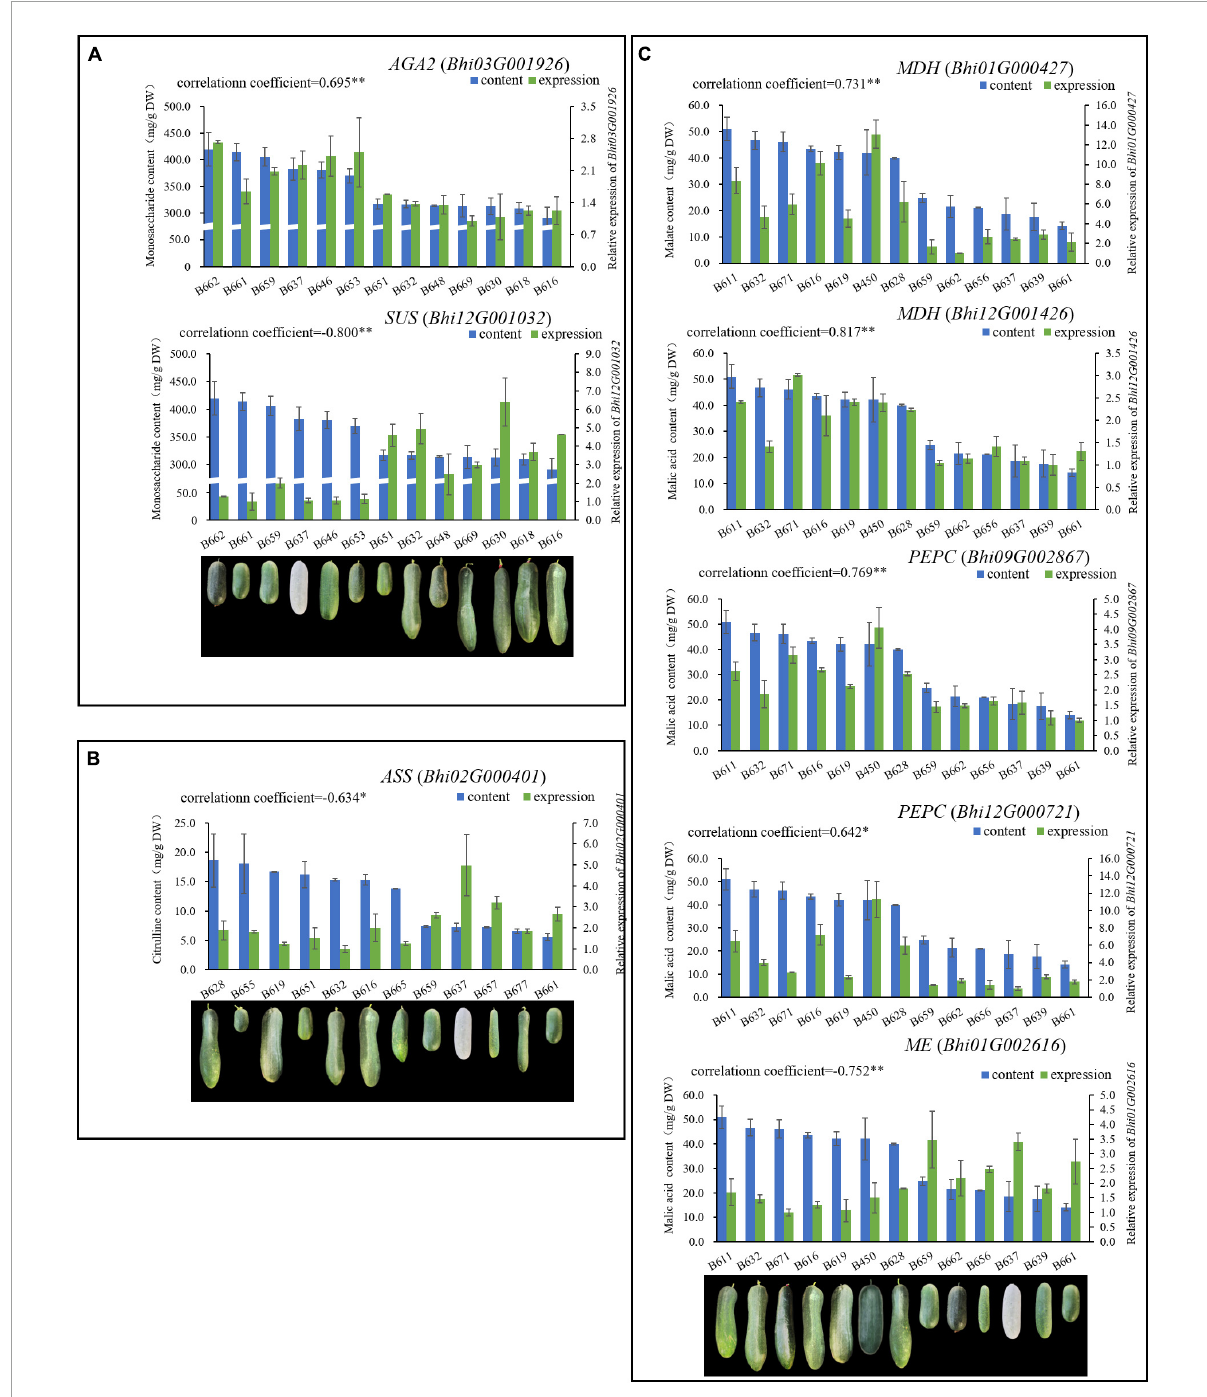
FIGURE4 A total of 8 genes related to sugar [ AGA2 ( Bhi03G001926 ), SUS ( Bhi12G001032 )], malic acid [ MDH ( Bhi12G001426 , Bhi01G000427 ), PEPC ( Bhi12G000721 , Bhi09G002867 ), ME ( Bhi01G002616 )] and citrulline [ ASS ( Bhi02M000401 )], respectively were determined, expression of which have high correlation with metabolite contents. (A) Genes related to sugar; (B) genes related to citrulline; (C) genes related to malic acid.